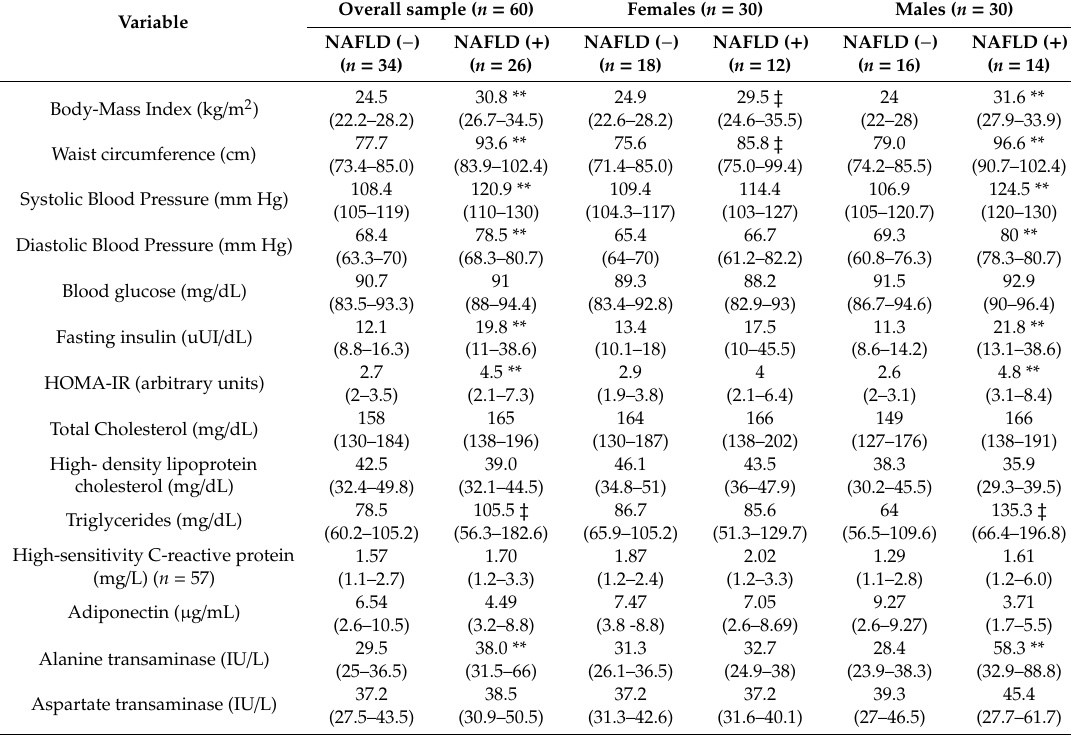
Table 3. Anthropometric features, blood pressure and blood parameters in participants with and without NAFLD, according to Ultrasound (Hamaguchi score ≥ 4) expressed as median (interquartile range).